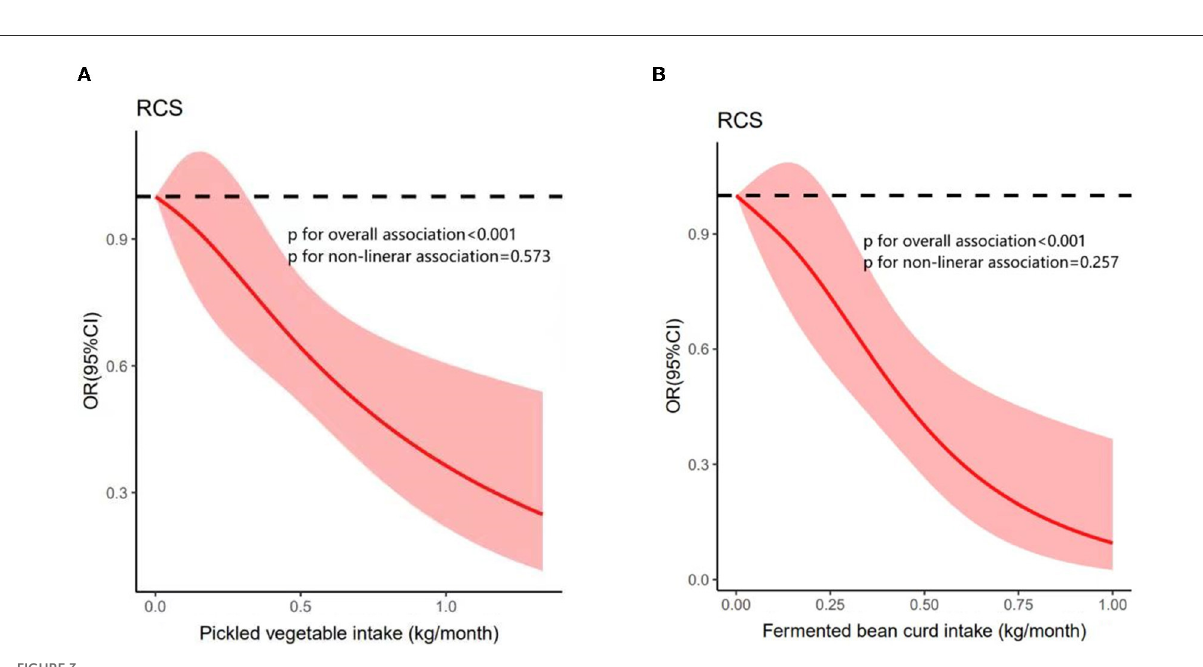
FIGURE3 Adjusted ORs (solid line) and 95% Cls (pink shaded area) for the associations of (A) pickled vegetable intake and (B) fermented bean curd intake with diabetes. The red line represents the estimated OR of diabetes and the pink shaded area represents the 95% Cl around this. The dashed line represents the OR =